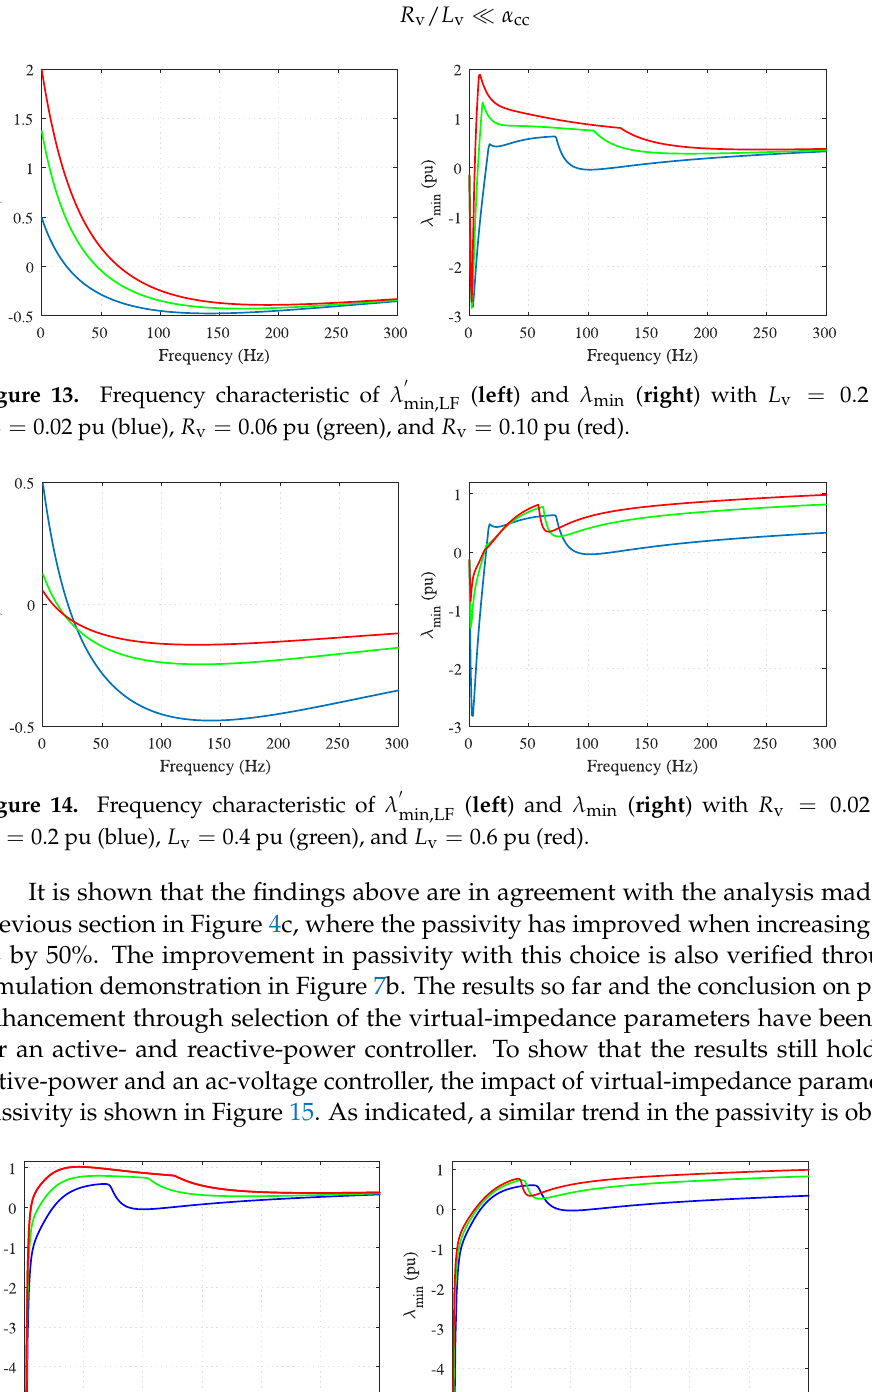
Figure 15. Left : Frequency characteristic of λ min with active-power and ac-voltage controller for L v = 0.2 pu and R v = 0.02 pu (blue), R v = 0.06 pu (green), and R v = 0.10 pu (red); Right : Frequency characteristic of λ min with active-power and ac-voltage controller for R v = 0.02 pu and L v = 0.2 pu (blue), L v = 0.4 pu (green), and L v = 0.6 pu